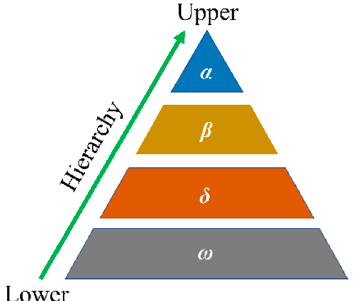
Figure 2. Hierarchy of wolf in GWO algorithm.